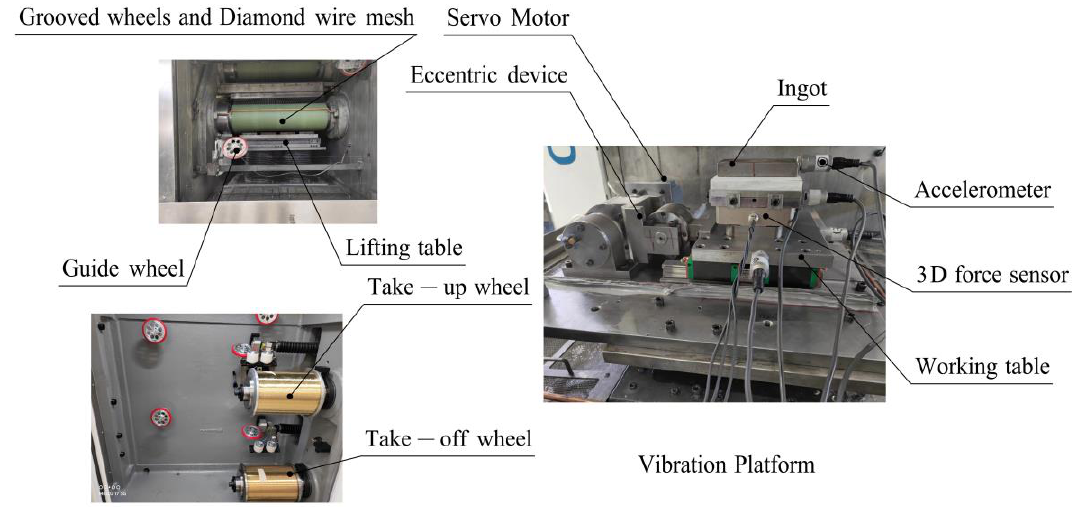
Figure 6. The structure of the experimental machine tool.